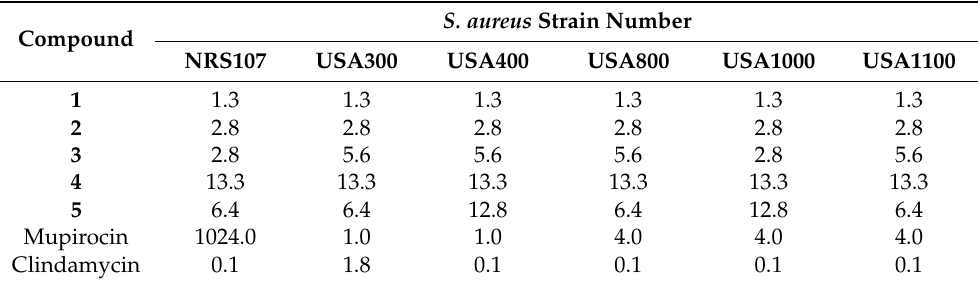
Table 3. Minimum inhibitory concentration (MIC in µ g/mL) of thiazole compounds 1 – 5 , clindamycin and mupirocin (tested in triplicate) against MRSA and mupirocin-resistant S. aureus (NRS107) strain isolated from skin wounds [105].